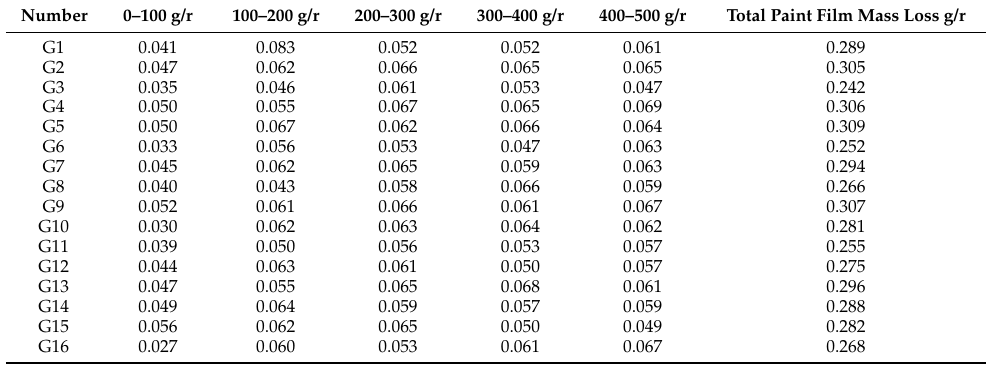
Table 9. Measurement of paint film mass loss.